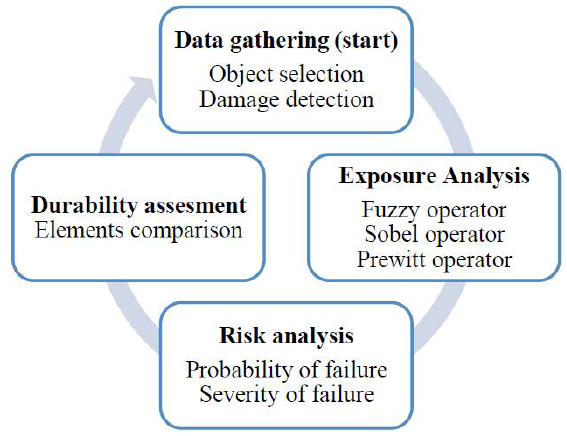
Figure 3. Research Figure 3. Research process.